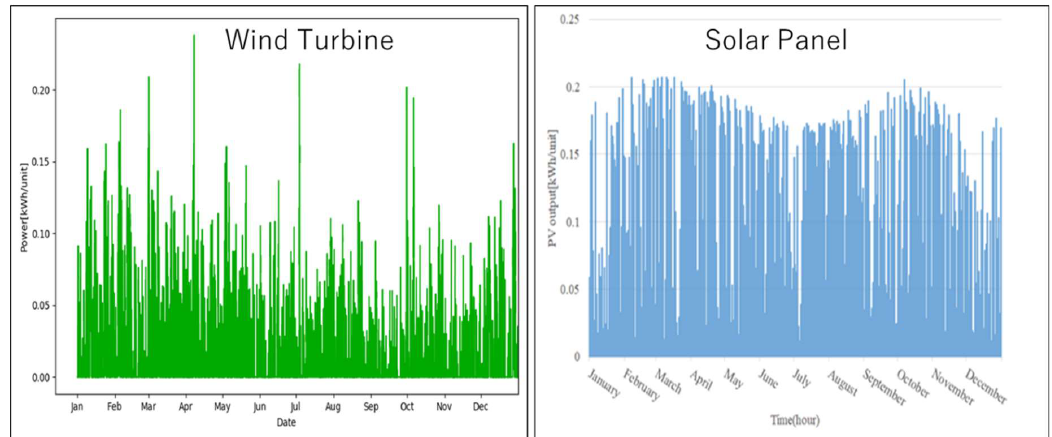
Figure 19. Estimated power output per each unit of PV panel and wind turbine.